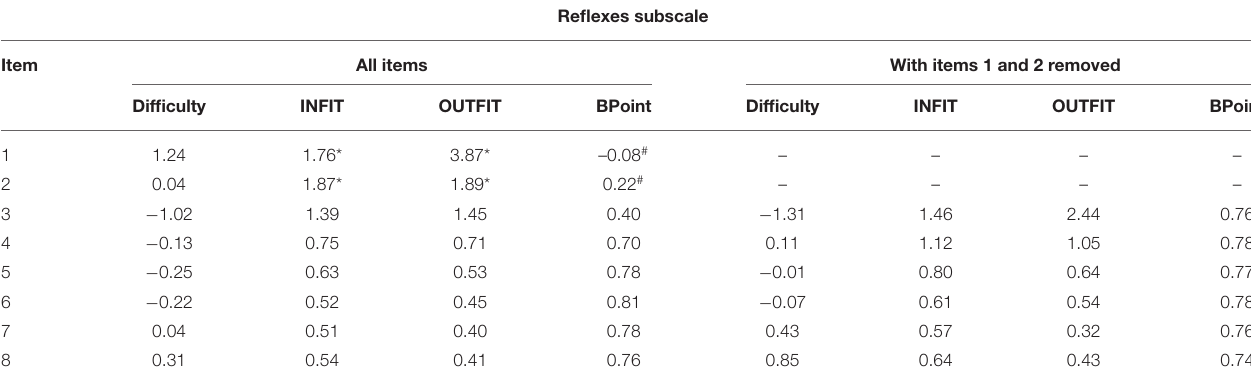
TABLE 2 | Reflexes subscale: item difficulty, INFIT, OUTFIT, and point-biserial correlations before and after removing items.